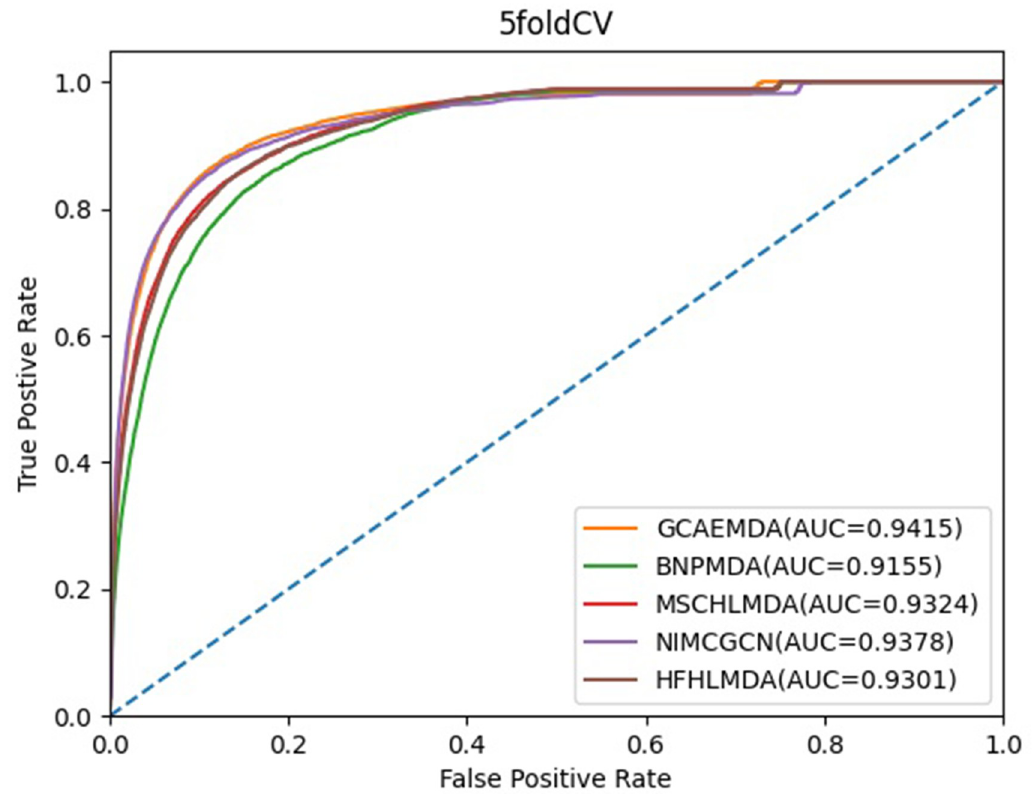
Fig 5. AUC of 5-CV compared with those of BNPMDA, MSCHLMDA, NIMCGCN and